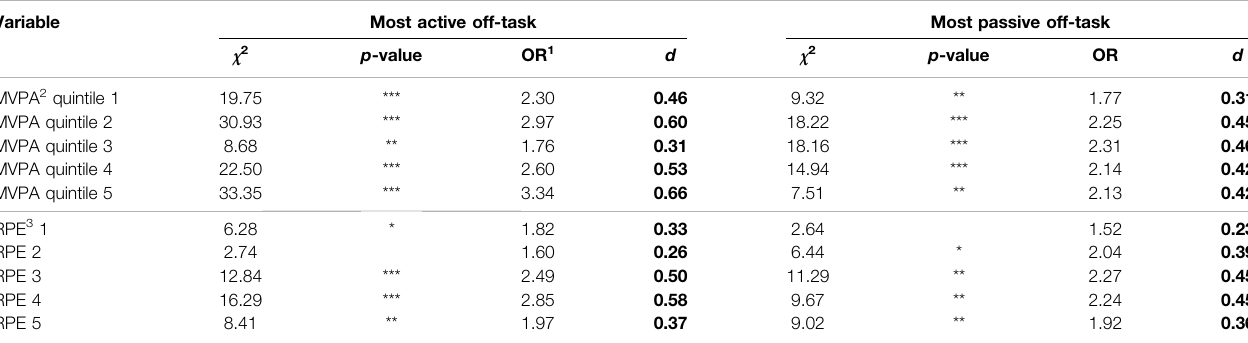
TABLE 6 | Response of on-task behaviour to objective and subjective PA in the most off-task sub-samples.